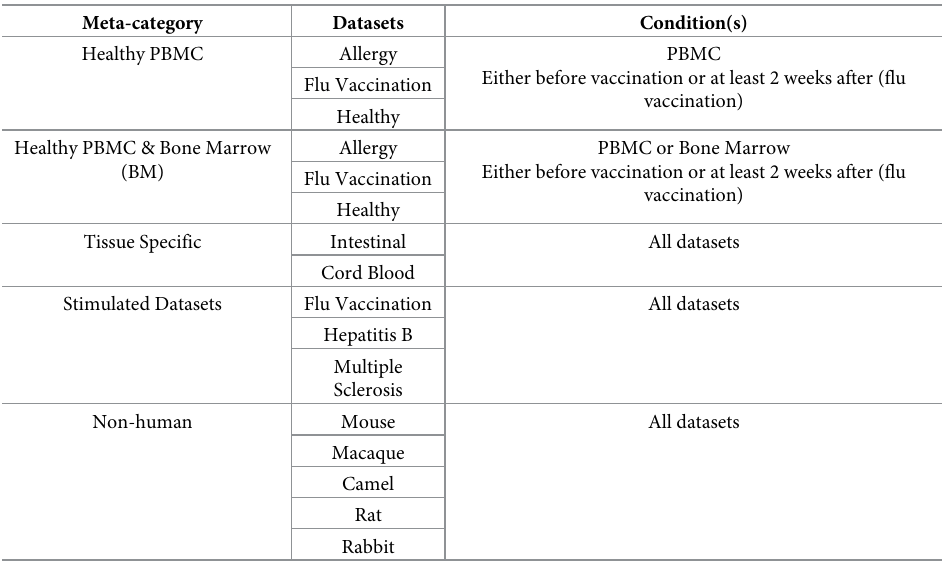
Table 1. Meta-categories of